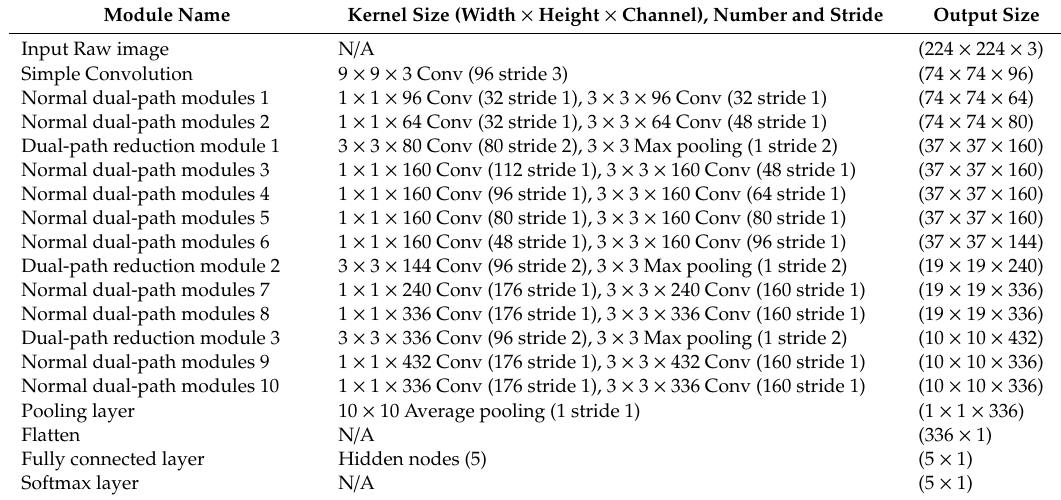
Table 2. The CNN architecture modified for training on higher resolution